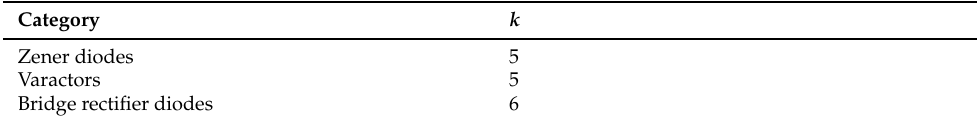
Figure 8. Accuracies with respect to different k values for ( a ) Zener diodes, ( b ) varactors, and ( c ) bridge rectifier diodes. Table 6. Optimal k values for the three categories.